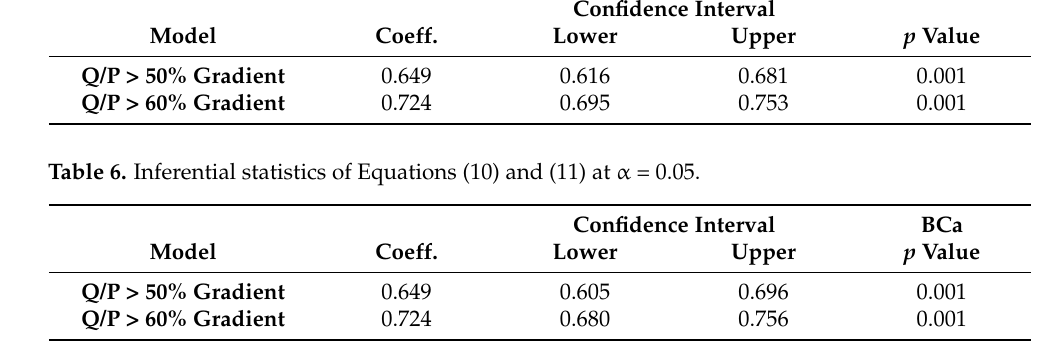
Table 5. Descriptive statistics of Equations (10) and (11) at α = 0.05. Confidence Interval Model Coeff. Lower Upper p Value Q/P > 50% Gradient 0.649 0.616 0.681